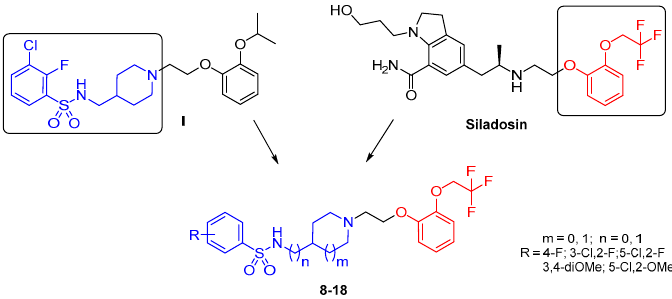
Figure 2. Design strategy for arylsulfonamide derivatives of alicyclic amines as silodosin analogs.